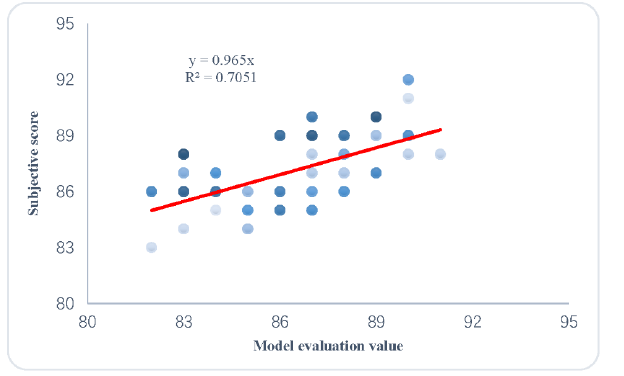
Fig. 9 Evaluation correlation analysis of greening facilities.